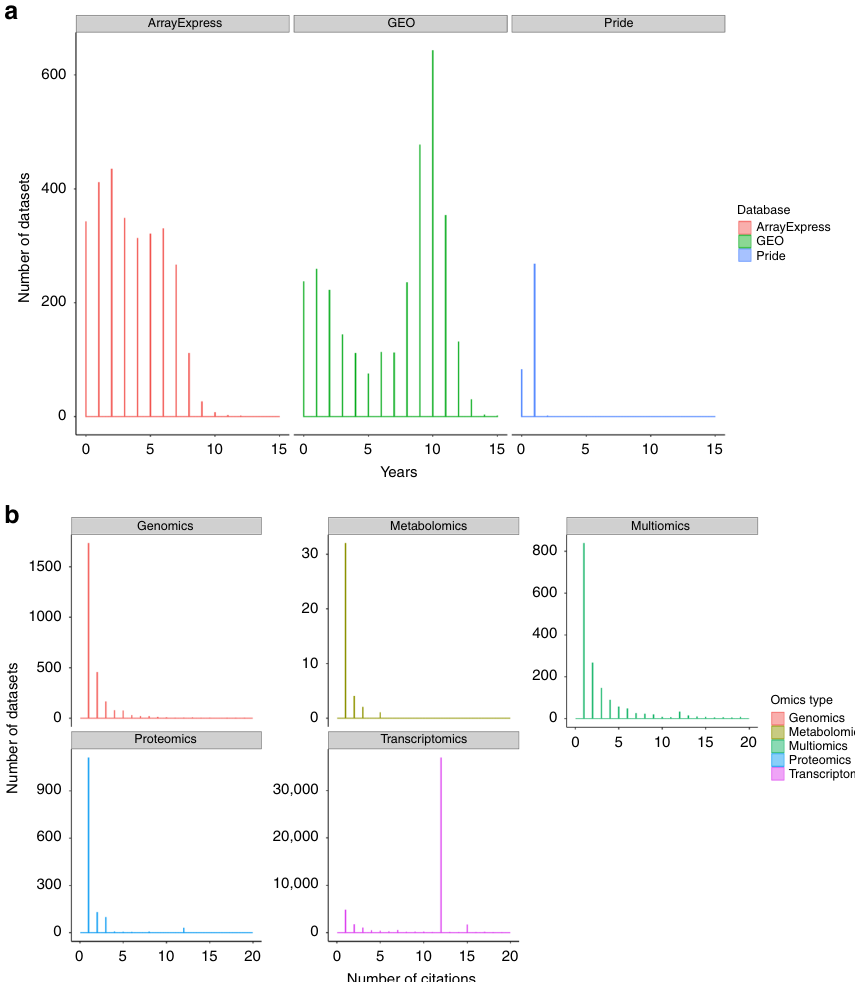
Fig. 2 a Elapsed time between the original publication of a dataset and the publication of all its reanalyses for three omics data archives (PRIDE — Proteomics, GEO — Transcriptomics, ArrayExpress — Transcriptomics). Transcriptomics datasets tend to be reanalysed over time until datasets are 12 years old, while proteomics datasets (PRIDE) are less reused after 3 years from their publication. b Distribution of the number of citations per dataset group by OmicsDI omics type. Transcriptomics datasets are highly cited with more than 30,000 datasets with 11 citations; while in genomics, proteomics and metabolomics most datasets are only cited